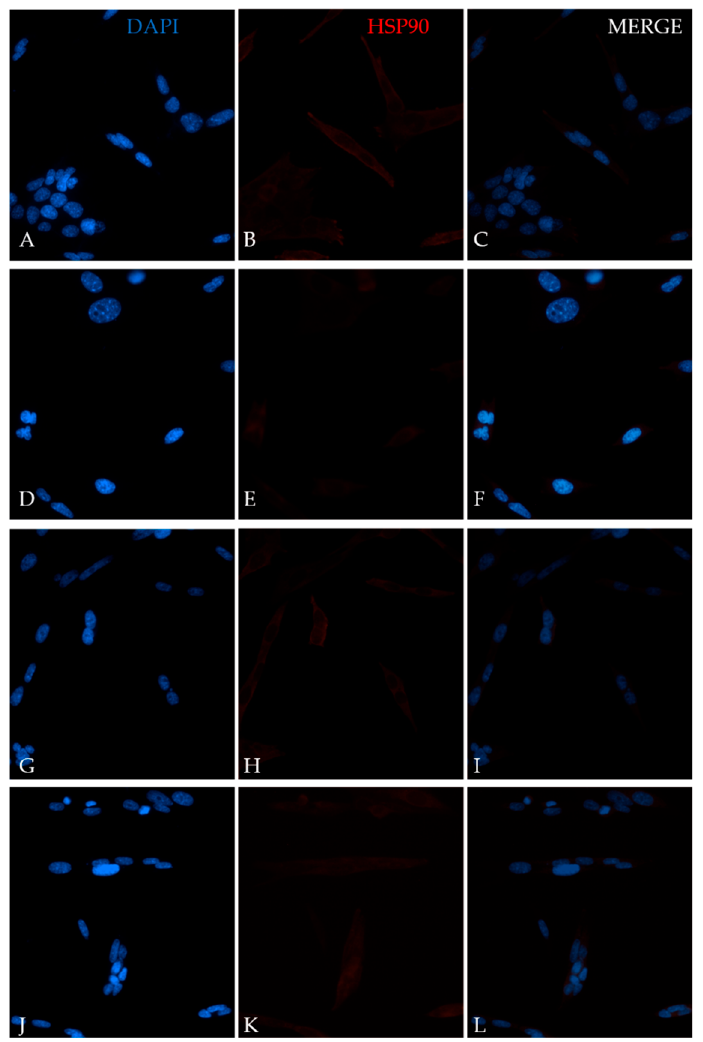
Figure 4. Immunofluorescence analysis of HSP90 expression in CT2A exposed to a 100 μ T EMF (Microscope 20×): ( A ) CT2A control group (non-exposed), nuclei staining with DAPI; ( B ) CT2A control group (non-exposed) HSP90AB expression; ( C ) merge of A and B; ( D ) CT2A after the exposure to a 100 μ T EMF at 20 Hz, nuclei staining with DAPI ; ( E ) CT2A after the exposure to a 100 μ T EMF at 20 Hz, HSP90AB expression; ( F ) merge of D and E; ( G ) CT2A after the exposure to a 100 μ T EMF at 30 Hz, nuclei staining with DAPI; ( H ) CT2A after the exposure to a 100 μ T EMF at 30 Hz, HSP90AB expression; ( I ) merge of G and H; ( J ) CT2A after the exposure to a 100 μ T EMF at 50 Hz, nuclei staining with DAPI; (K) CT2A after the exposure to a 100 μ T EMF at 50 Hz, HSP90AB expression; ( L ) merge of A and B.